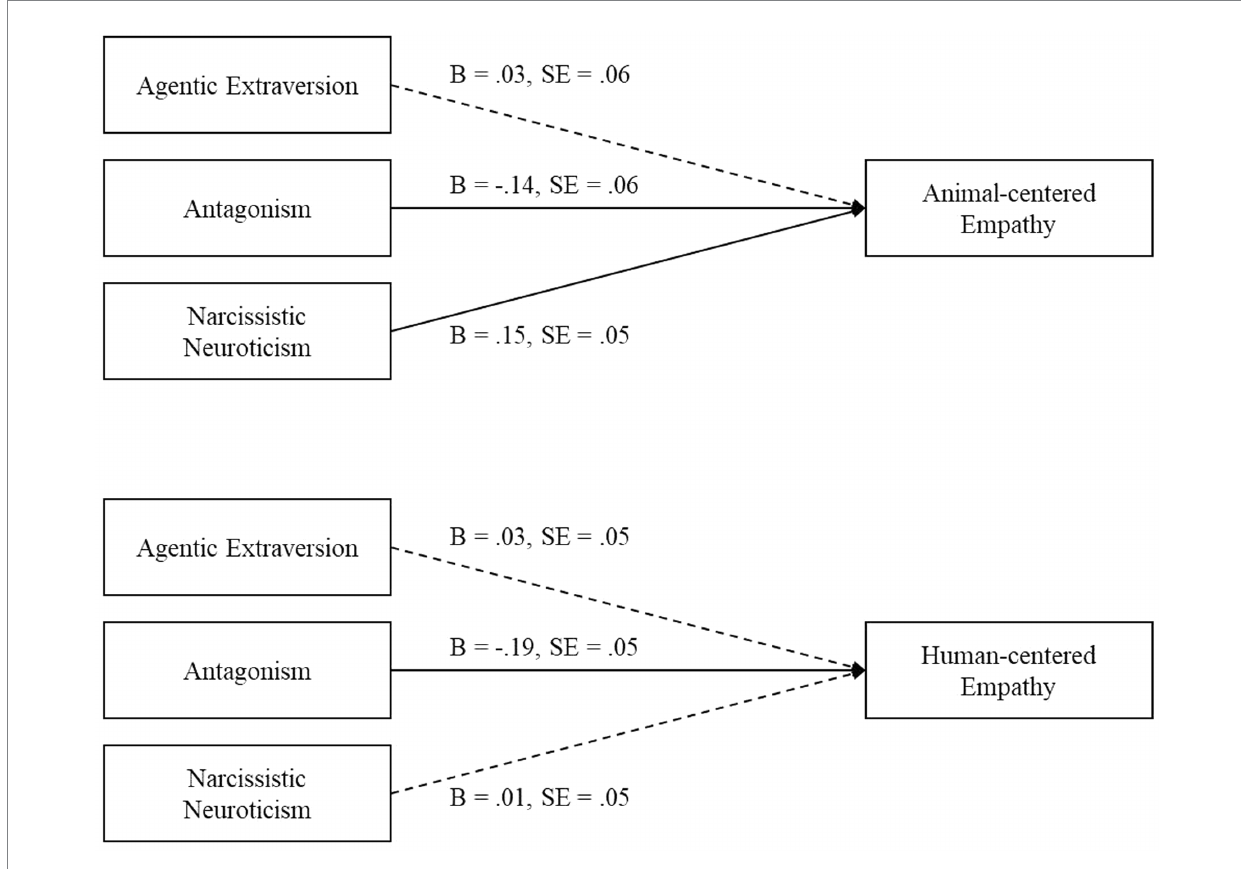
FIGURE 2 A summary of the regression analyses where Agentic Extraversion, Antagonism, and Narcissistic Neuroticism predict animal-centered empathy and human-centered empathy, controlling for gender, human-centered empathy, and animal-centered empathy, respectively. Solid lines indicate significant